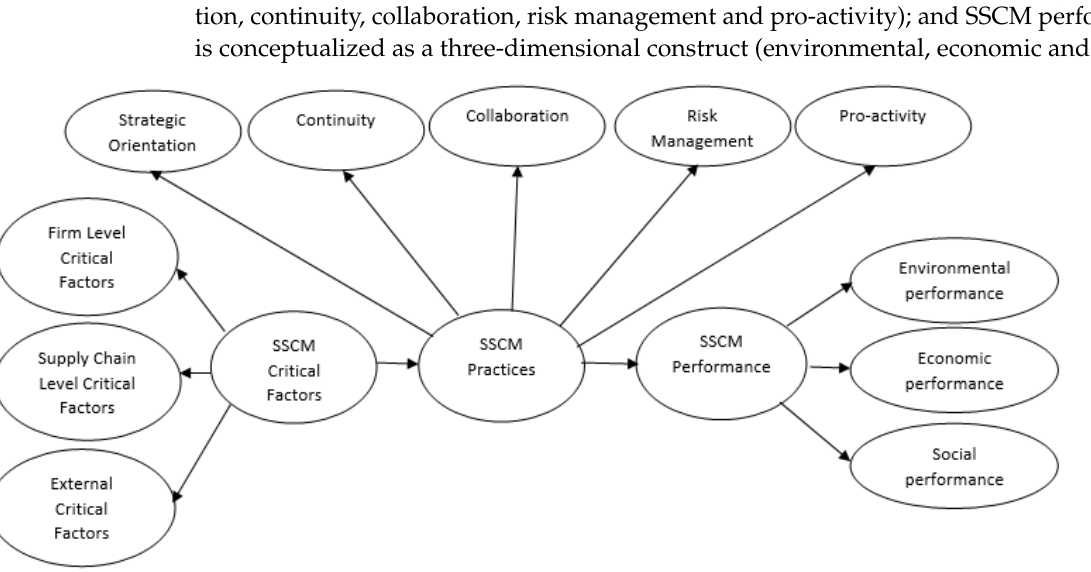
Figure 2. Proposed theoretical framework linking critical factors, practices and performance (based on the literature). on the